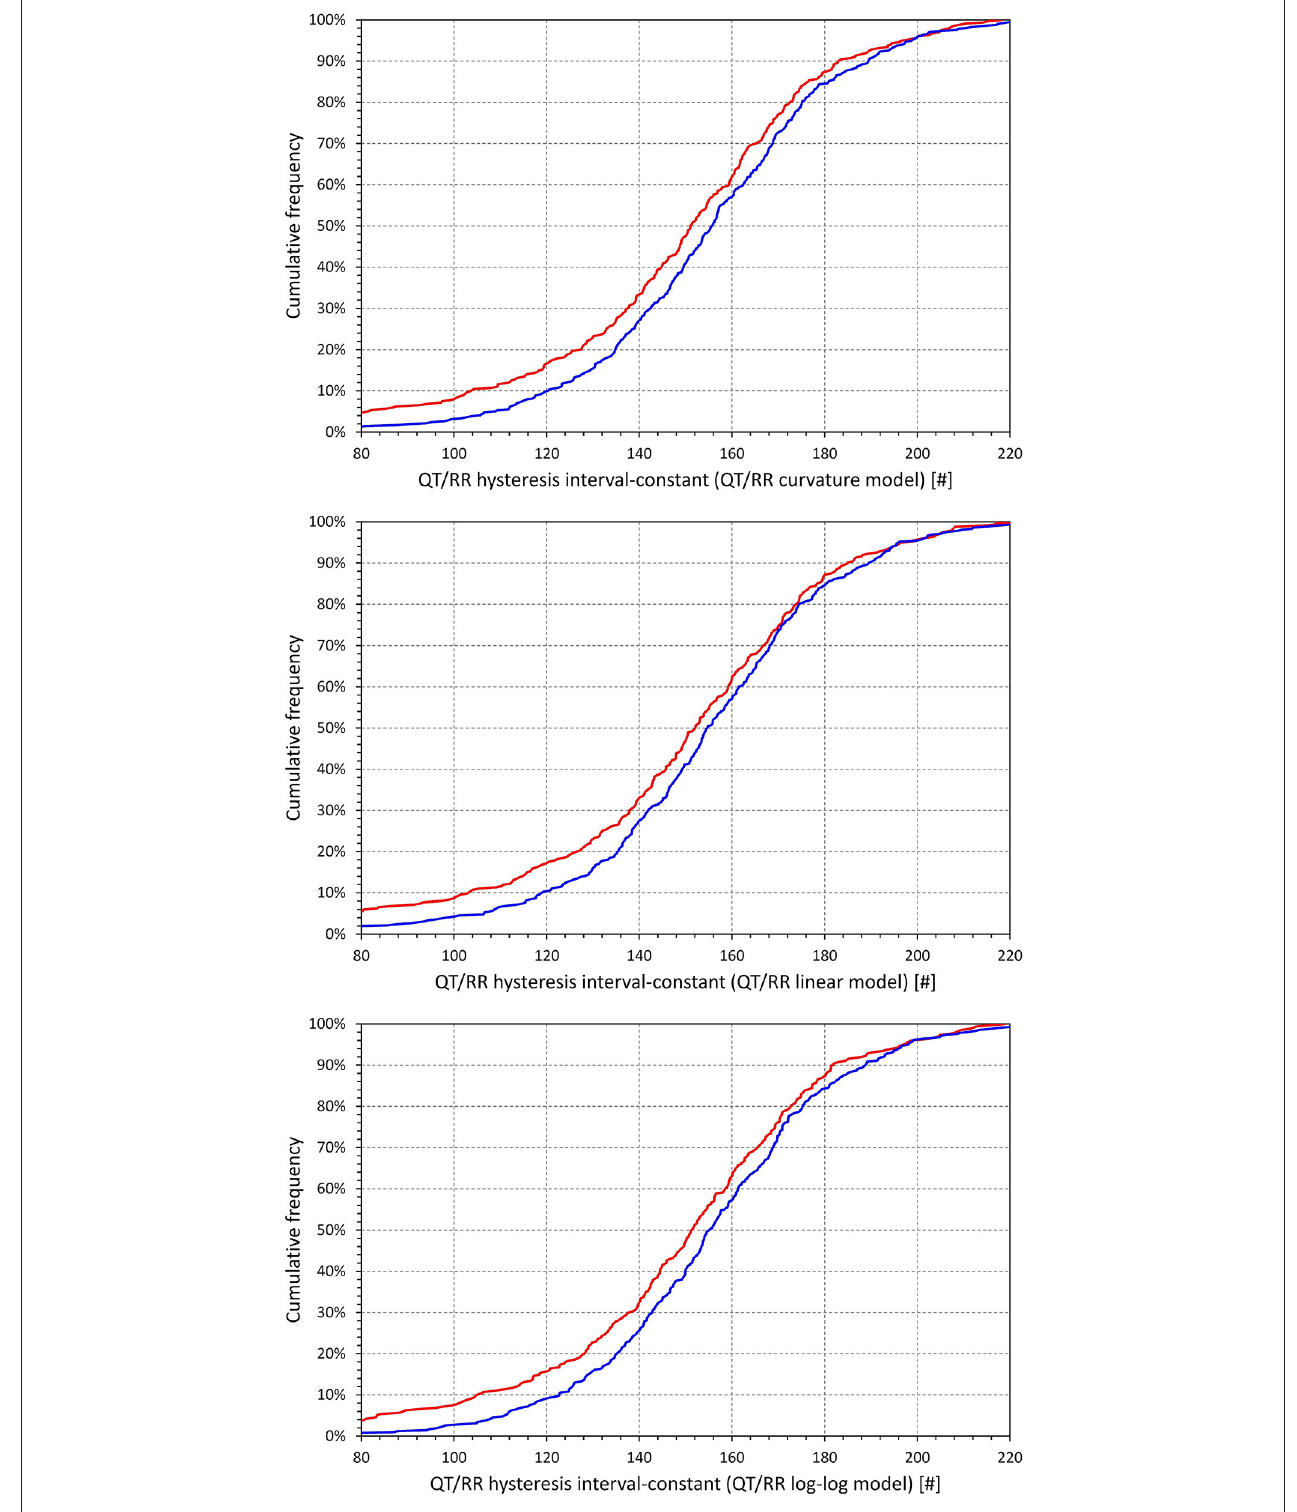
FIGURE 8 | Cumulative distributions of QT/RR hysteresis interval constants derived from the combination with the QT/RR H curvature model (top panel), linear model (middle panel), and log-log model (bottom panel). In each of the panels, the red and blue lines correspond to females and males, respectively.